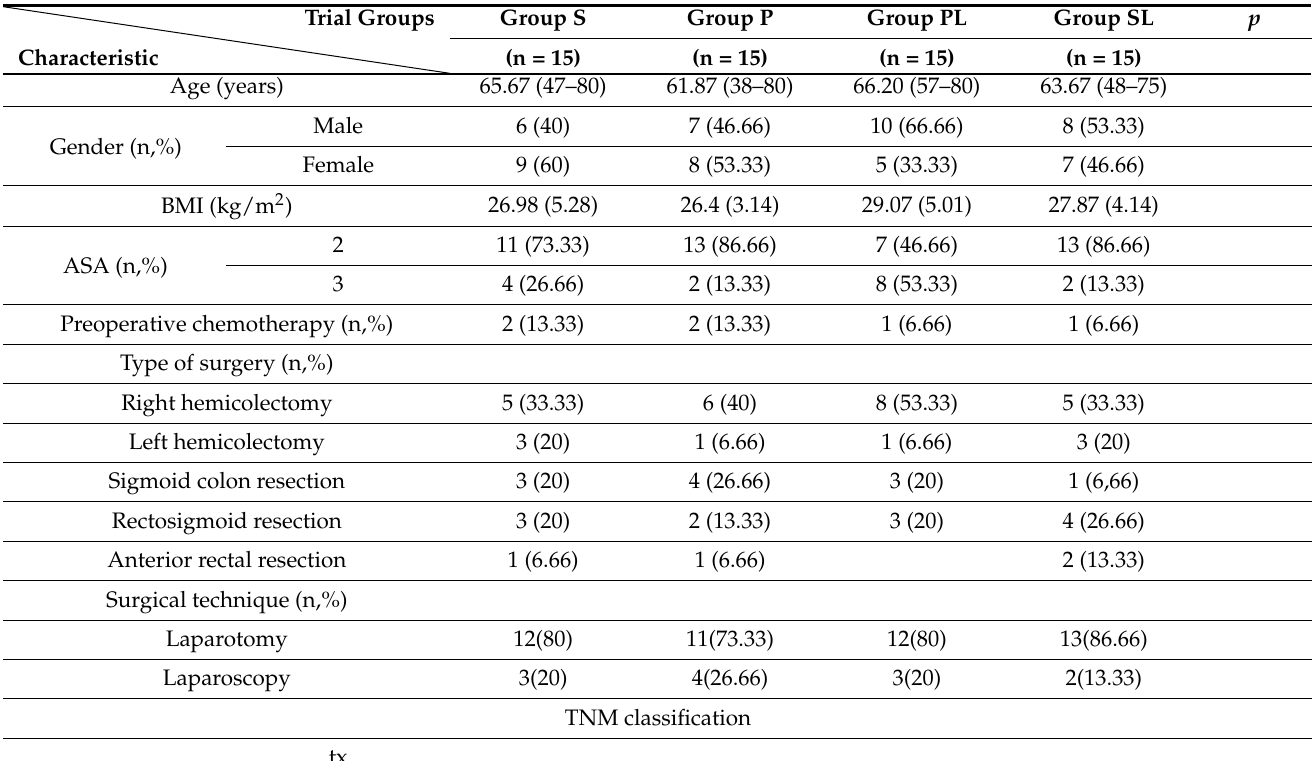
Table 1. Patients’ colorectal tumor characteristics. The data are shown as the mean (standard deviation) or n = patients’ number